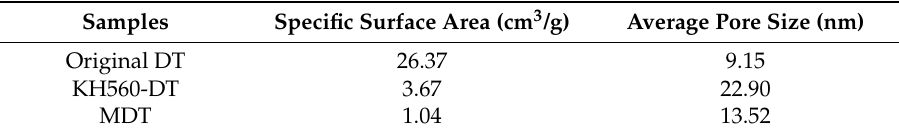
Table 2. Specific surface area and average pore size of different types of diatomites.